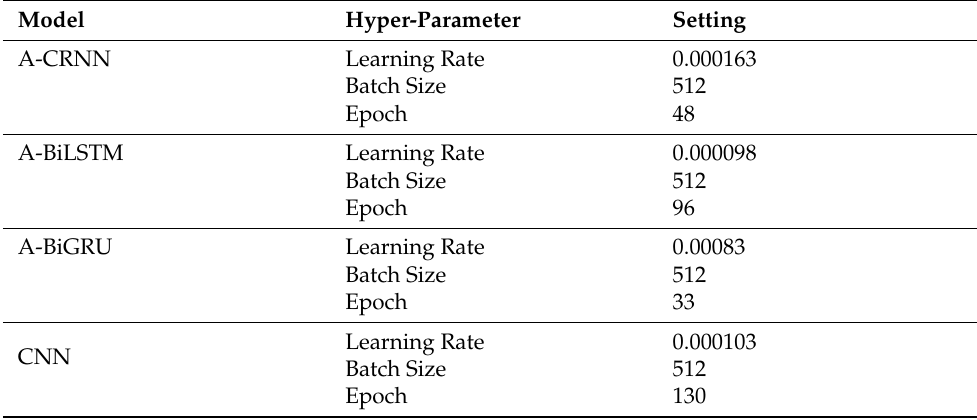
Table 12. Optimized hyper-parameter settings with respect to D4.